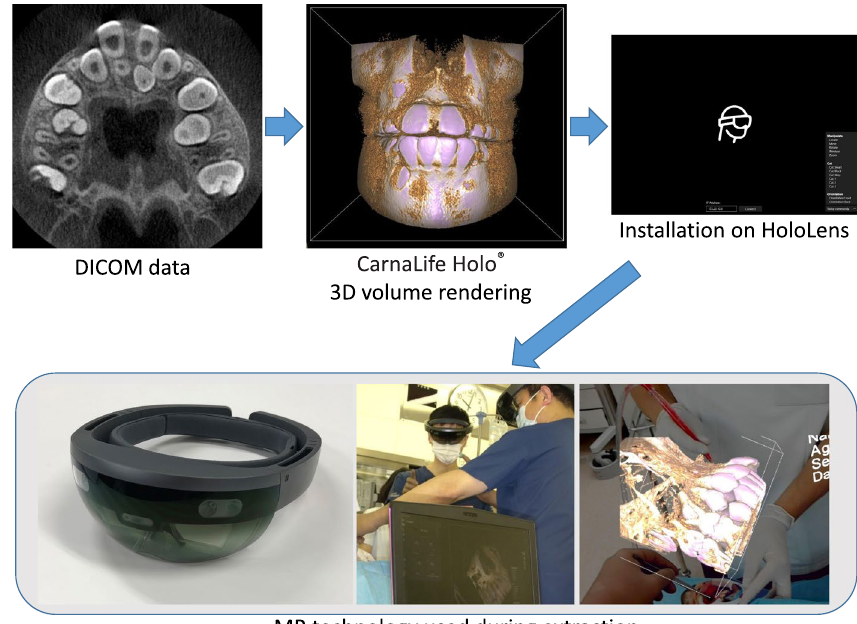
Fig. 1 Preoperative preparation and MR technology used during